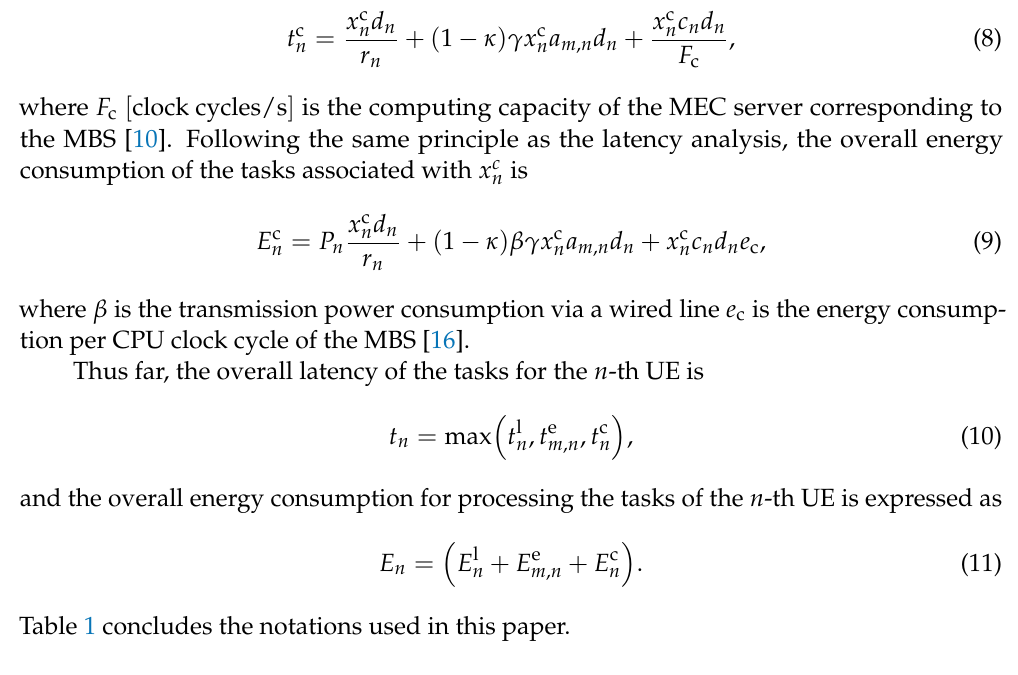
Table 1 concludes the notations used in this